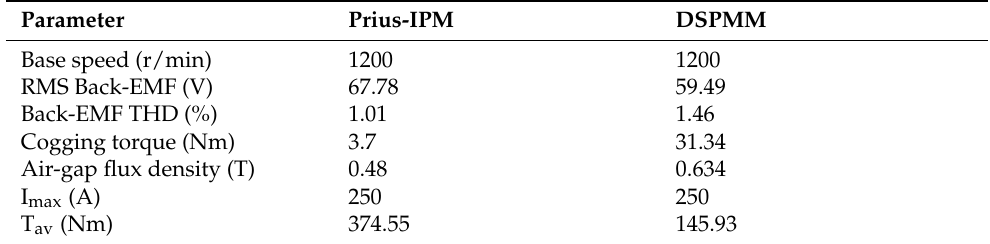
Table 3. Quantitative comparison of Prius-IPM and